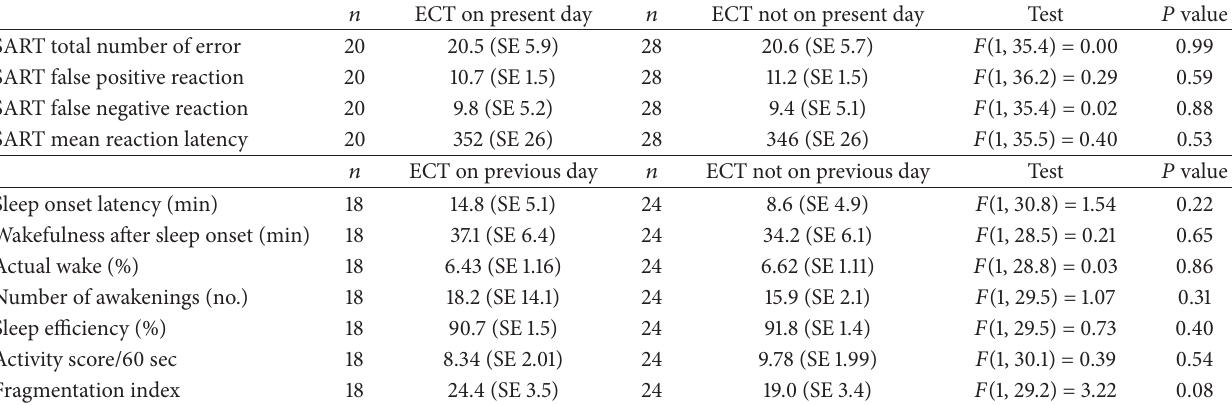
Table 3: Effects of electroconvulsive therapy on objective parameters in 12 patients with a depressive episode. 𝑛 ECT on present day 𝑛 ECT not on present